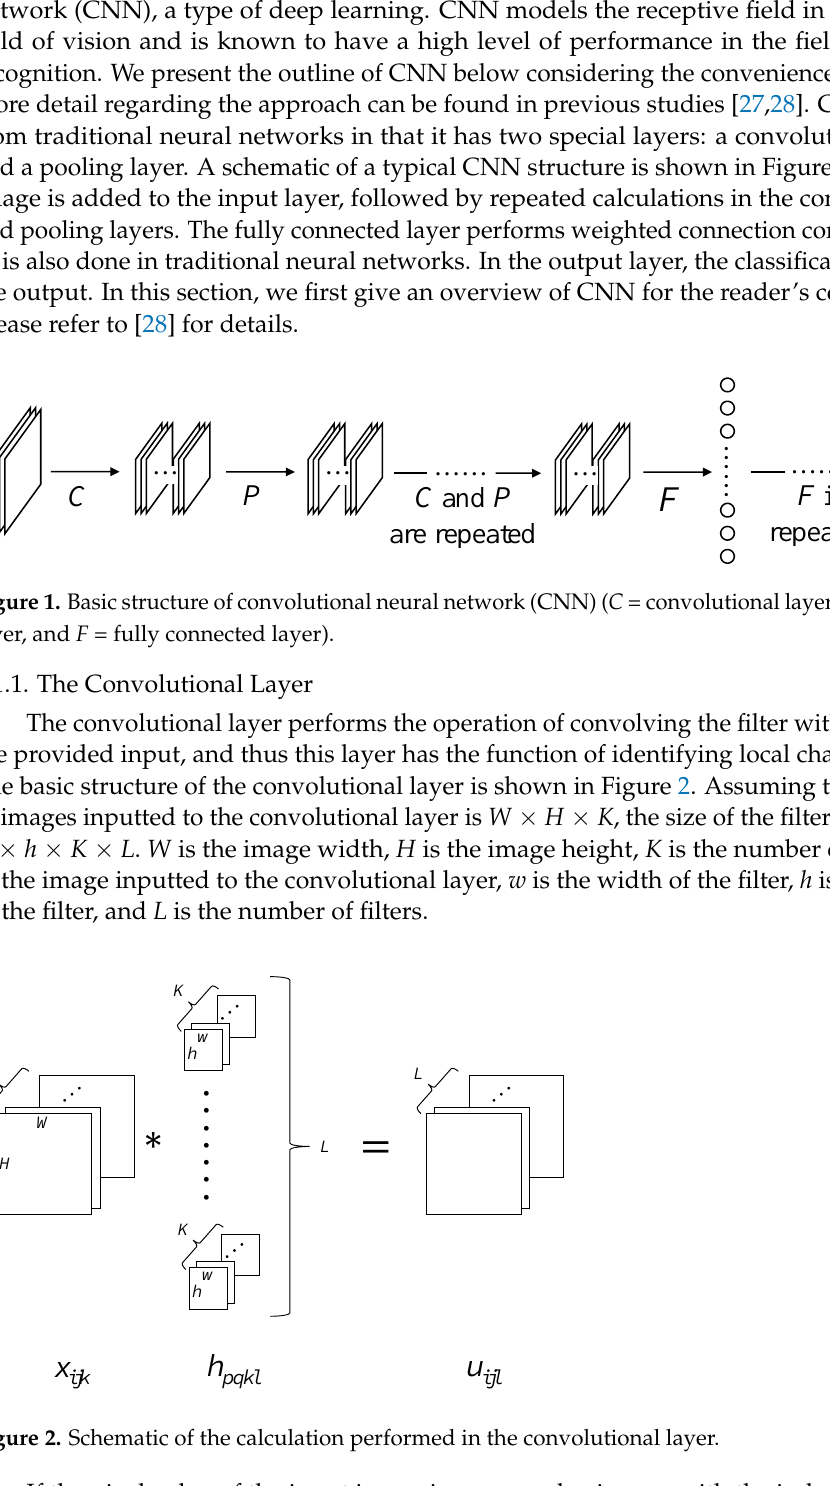
. . . , W − 1, j = 0, . . . , H − 1, k = 1, . . . , K ) and the pixel value of the filter using h …, W − 1, j = 0, …, H − 1, k = 1, …, K ) and the pixel value of the filter using h pqkl ( l = 1, …, L )